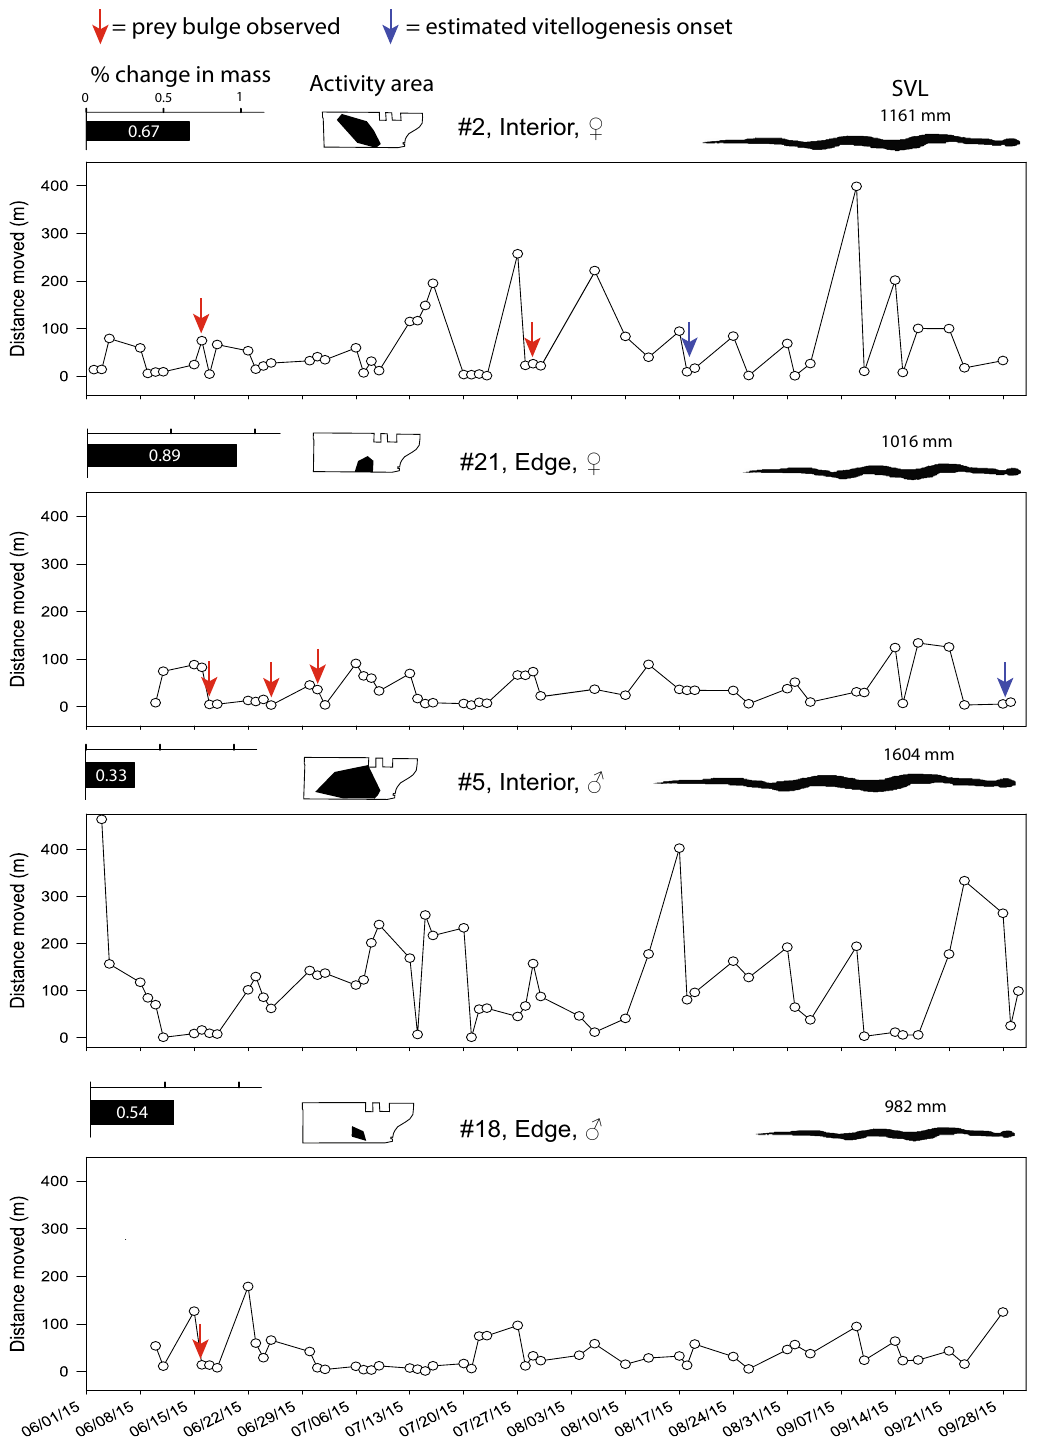
Figure 1. Movement patterns (average linear distance moved per day) on Guam of four radiotracked BTS in this study. Within each plot, we have indicated times when a prey bulge (indicative of prey consumption) was observed (red arrows) and, for females, estimated onset of vitellogenesis (blue arrows, estimated using follicular growth data obtained from Mathies et al. 33 ). At the top of each movement plot is each snake’s % change in body mass (relative to mass at the time of transmitter implantation, precise value indicated as white text within bar), their activity area (minimum convex polygon [MCP] method) within the Habitat Management Unit (HMU, perimeter of HMU indicated as black outline), and their size in snout-vent length (SVL, relative size indicated by black snake silhouette with precise numerical value in mm